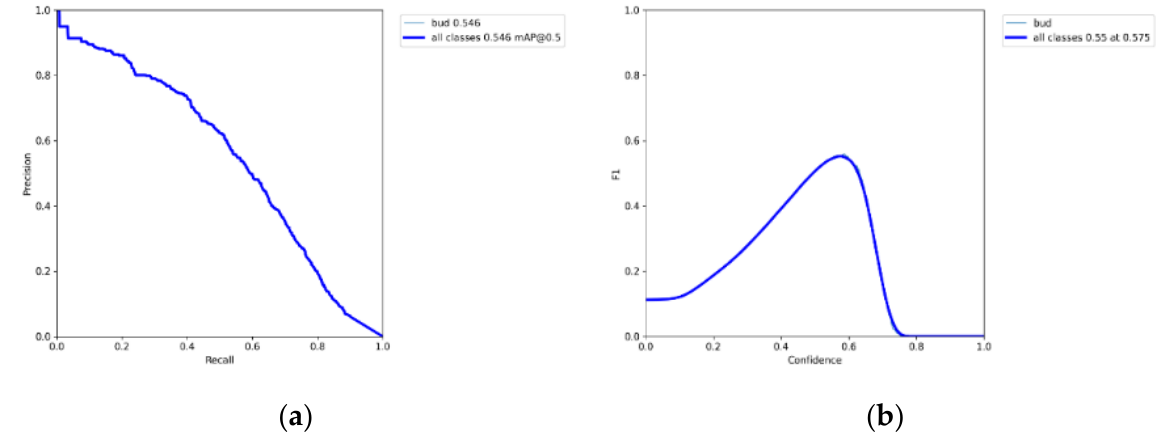
Figure A14. The precision/recall curve and F 1 Score /confidence curve of YOLOV5x: ( a ) PR_curve; ( b ) F1_curve.